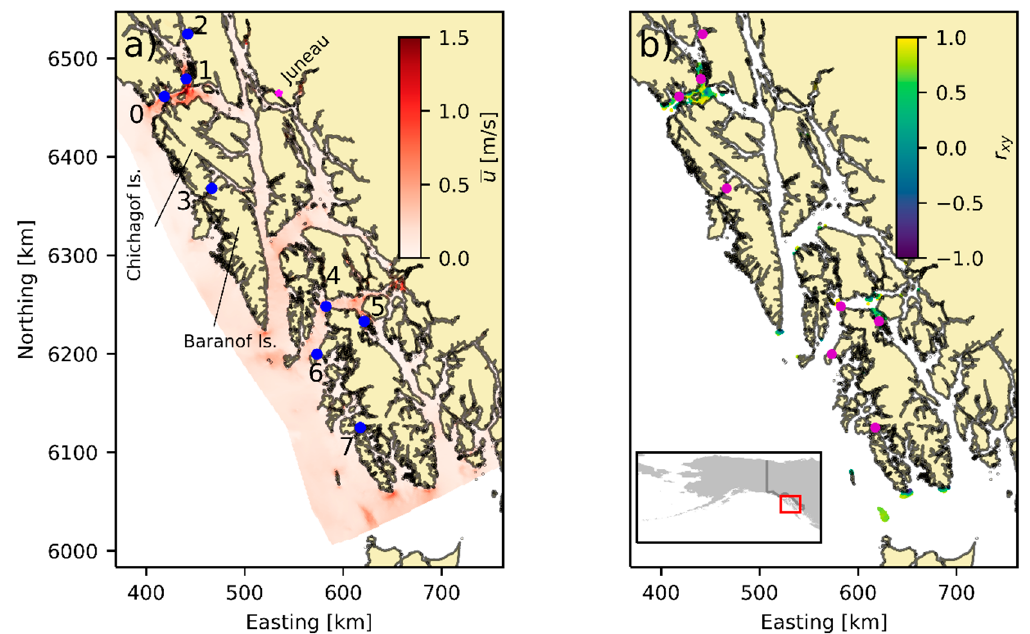
Figure 4. Cross-correlations for water surface elevation ( a ) and depth-averaged tidal currents ( b ) based on WY19 with respect to the open boundary point in magenta.